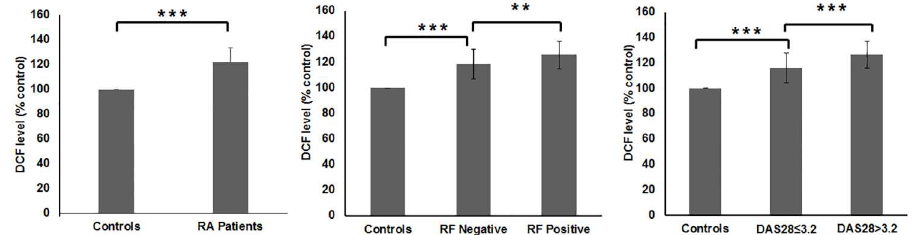
Fig 2. Bar graph representation of data from DCFH-DA assay on 10% hematocrit of control and RA patients (Fig A), seropositive and seronegative RA patients (Fig B) and patients having DAS28 (cid:20) 3.2 and those having DAS28 > 3.2 (Fig C). ( ** p < 0.01, *** p <